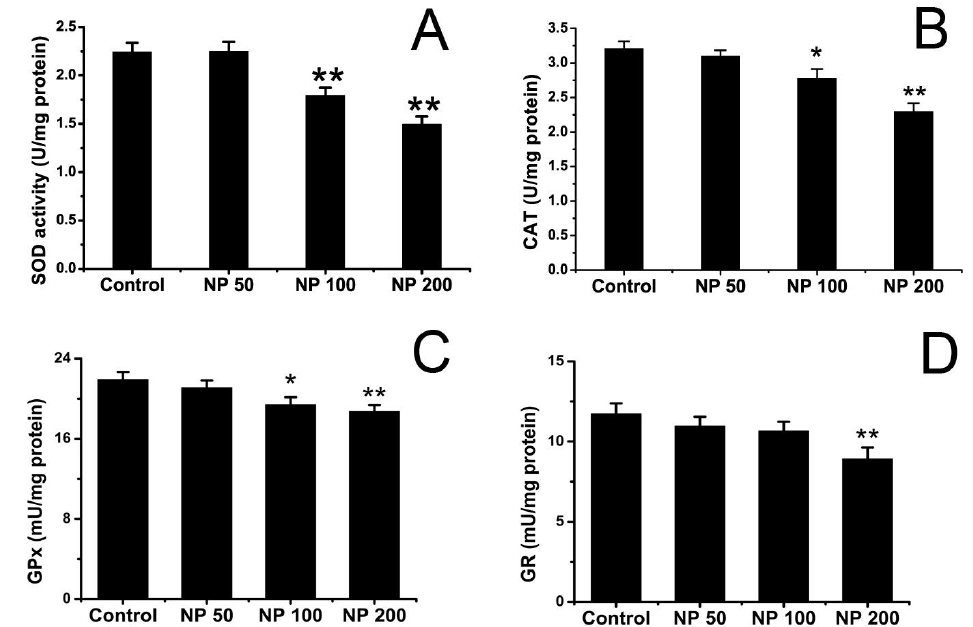
Figure 4. The effect of NP on SOD ( A ), CAT ( B ), GPx ( C ) and GR ( D ) activity in mouse brain ( n = 9). Values are expressed as mean ± S.E.M. * p < 0.05; ** p < 0.01 vs. the vehicle control.